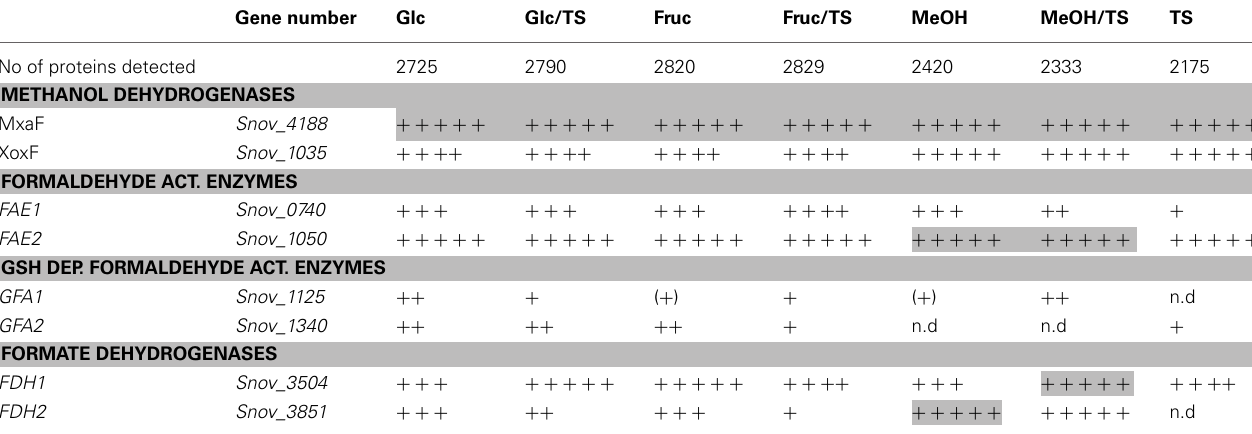
Table 3 | Presence of proteins involved in methylotrophy S. novella in cell extracts from chemolithoautotrophic, methylotrophic, heterotrophic and mixotrophic growth